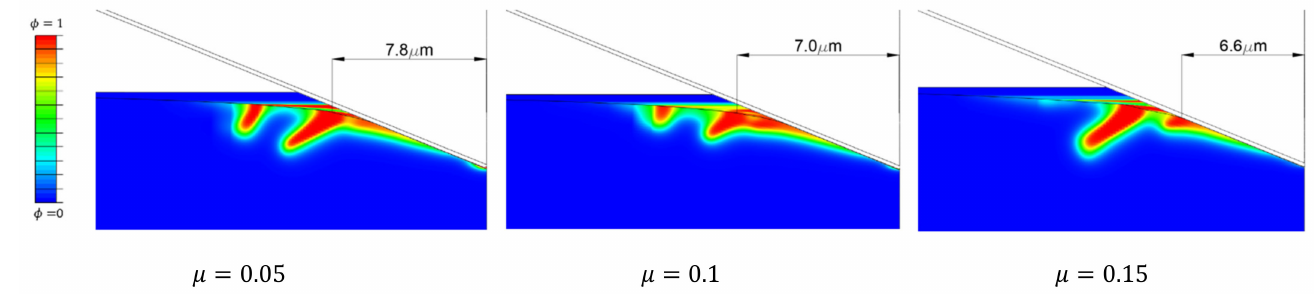
Figure 6. Comparison of the crack growth for different values of the friction coefficient, µ . All deformed models are under the same indenter penetration, i.e., h = 3 µ